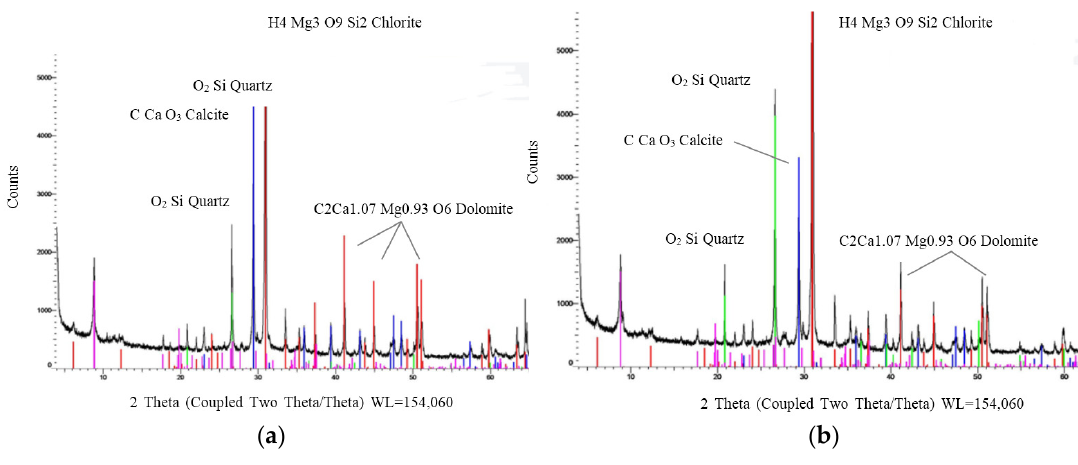
Figure 5. ( a ) X ‐ ray diffraction patterns of RCA; and ( b ) MRA Figure 5. ( a ) X-ray diffraction patterns of RCA; and ( b )